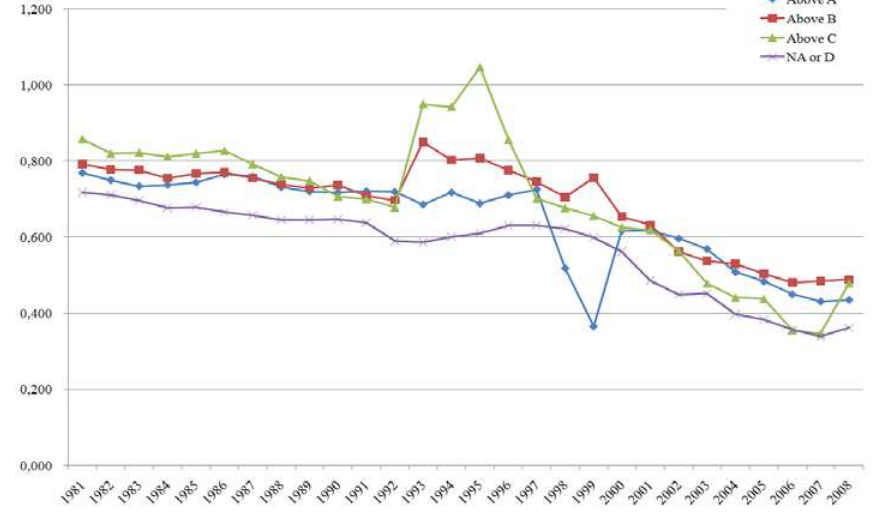
Fig. 6. Net leverage ratio by credit rating